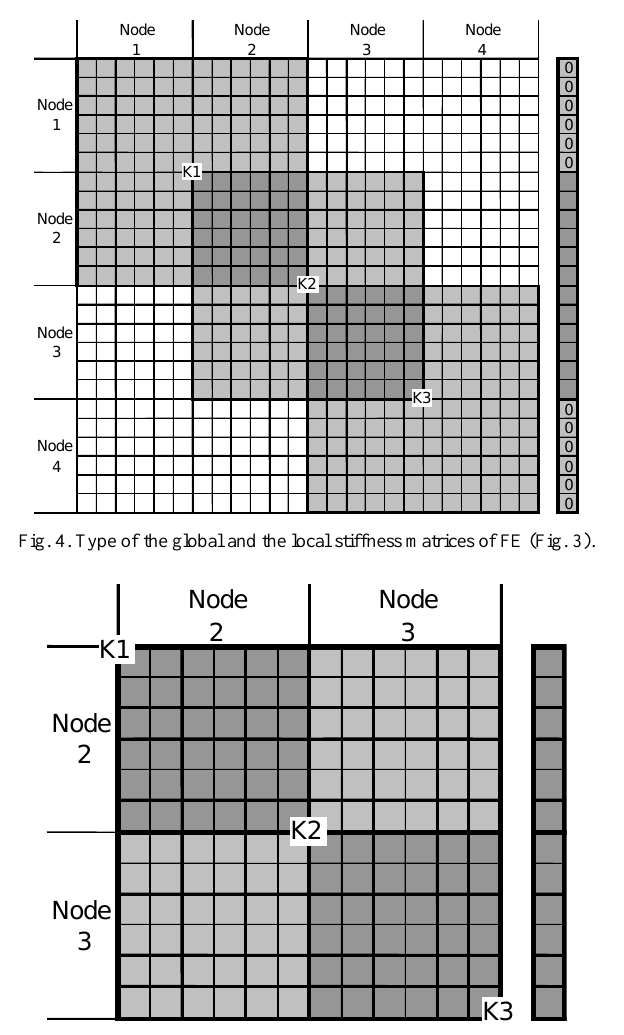
Fig. 5. Structure of the stiffness matrix of the system FE with the conditions of restraint for the 1st and 4th nodes. Subtracting from the global stiffness matrix of the system (9) the local units of matrices FE № 1 and № 3, we obtain the sought stiffness matrix of a two-node